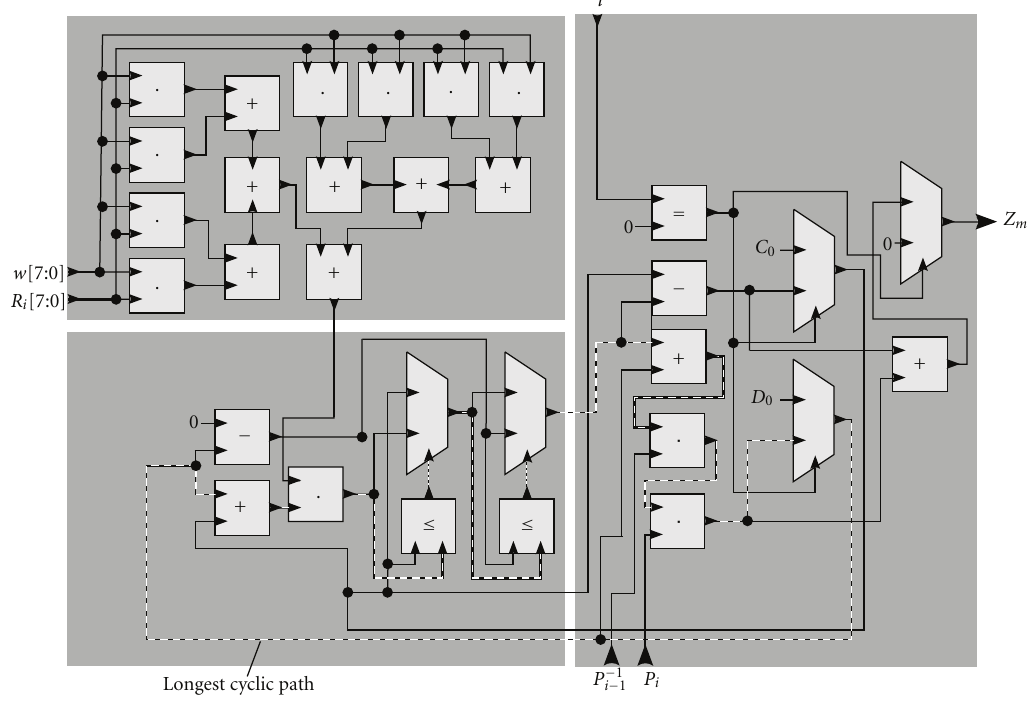
Figure 6: Scoring pipeline for 8 indicators.